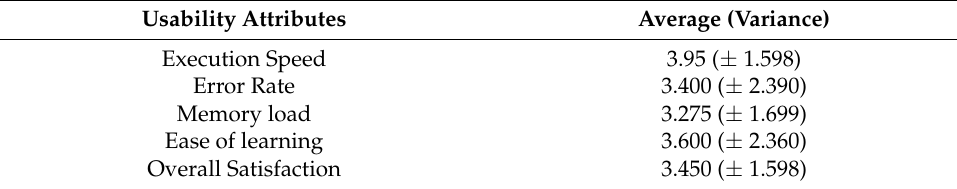
Table 3. Statistics of the different attributes of usability given by all users, values are in range